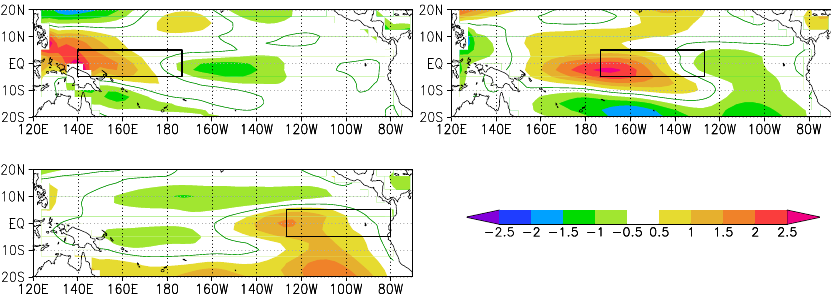
Fig. 3. The sensitivity of zonal wind stress anomalies to SST anomalies (term A in Eq. 2) of the STAM member [10 − 3 Nm − 2 K − 1 ]. The response is calculated using the three SST boxes highlighted on each figure panel. Orange-red colours correspond to eastward wind stress response to a positive SST anomaly in the indicated box, green-blue colours correspond to negative (westward) anomalies.